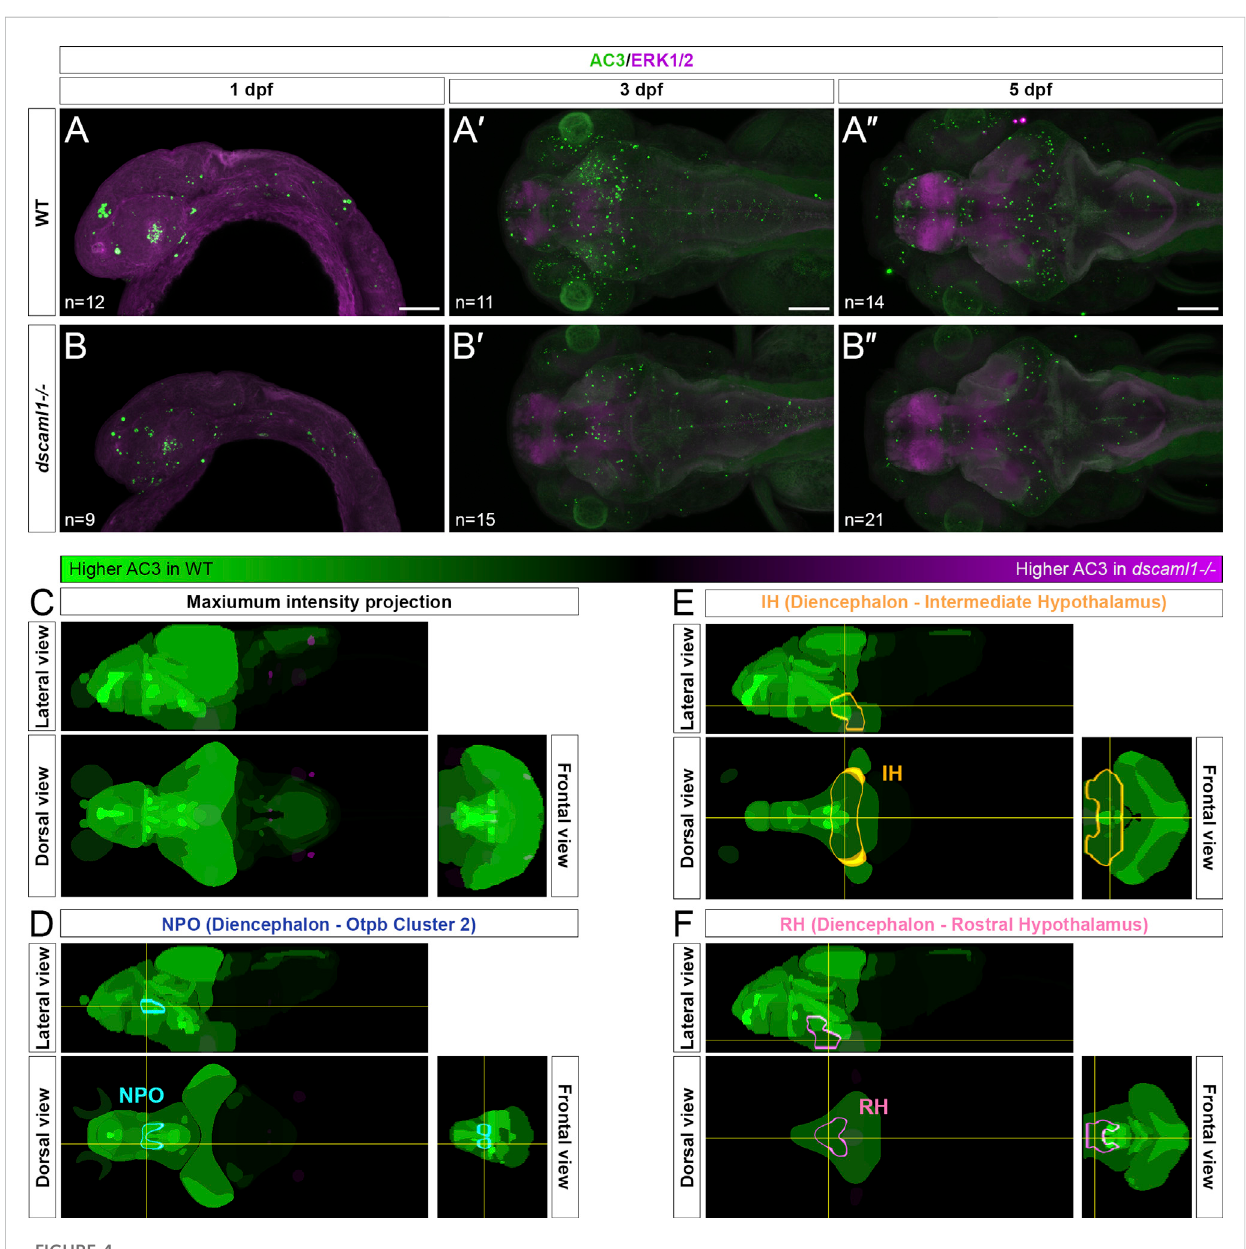
FIGURE 4 Programmed cell death in the brain is reduced in dscaml1 mutants. (A – B ” ) Immunolabeling with anti-AC3 (green) and counterstained with anti- ERK1/2 (magenta). 1 dpf embryos are shown laterally, and 3 and 5 dpf larvae dorsally. Wild-type (WT) animals are shown in panels A – A ” and dscaml1 − / − animals are shown in panels B – B ” . (C) 5 dpf Z-Brain mapping of brain regions, showing regions with higher AC3 labeling in WT (green) or dscaml1 − / − (magenta).Orthogonalmaximumintensityprojectionsareshown. (D) Z-BrainmappingintheNPO.Z-BrainROInameisindicatedintheparenthesis. Orthogonal sections are shown. (E) Z-Brain mapping in the IH. Z-Brain ROI name is indicated in the parenthesis. Orthogonal sections are shown. (F) Z-Brain mapping in the RH. Z-Brain ROI name is indicated in the parenthesis. Orthogonal sections are shown. Anterior is to the left for all images. Scale bars are 100 μ